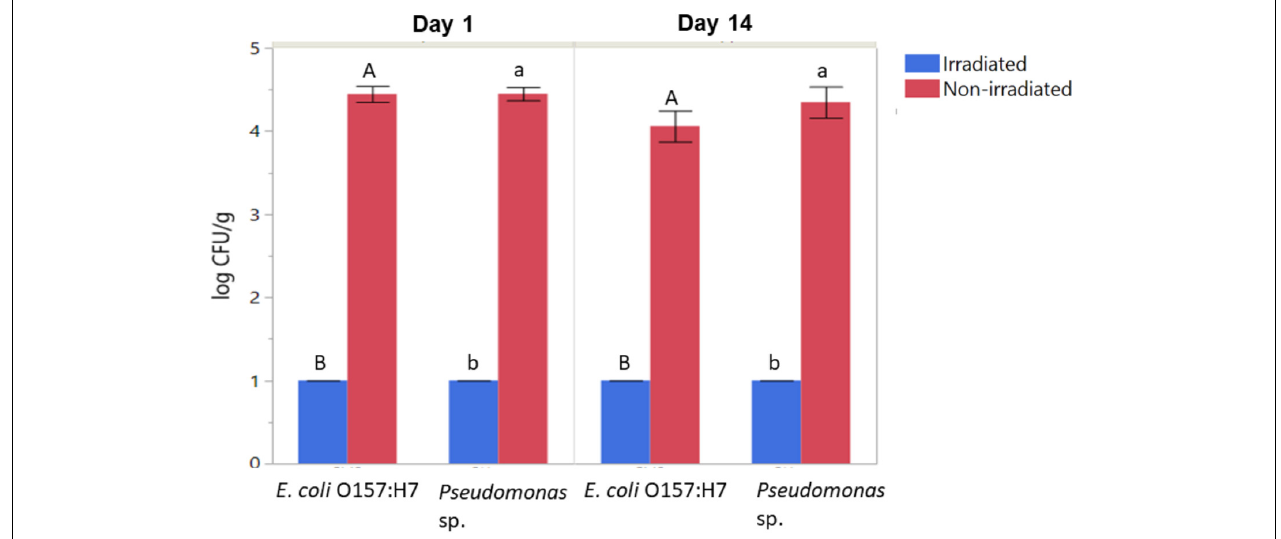
FIGURE 2 | Effect of irradiation on the survival and regrowth of inoculated antibiotic resistant E. coli O157:H7 and Pseudomonas after 1 and 14 days of storage at 4 ◦ C. Bars represent average log CFU/g and error bars represent standard error from the mean ( n = 3). Connecting letters indicate statistical significance among irradiated and non-irradiated samples as well as among days 1 and 14 samples (ANOVA, p < 0.05).